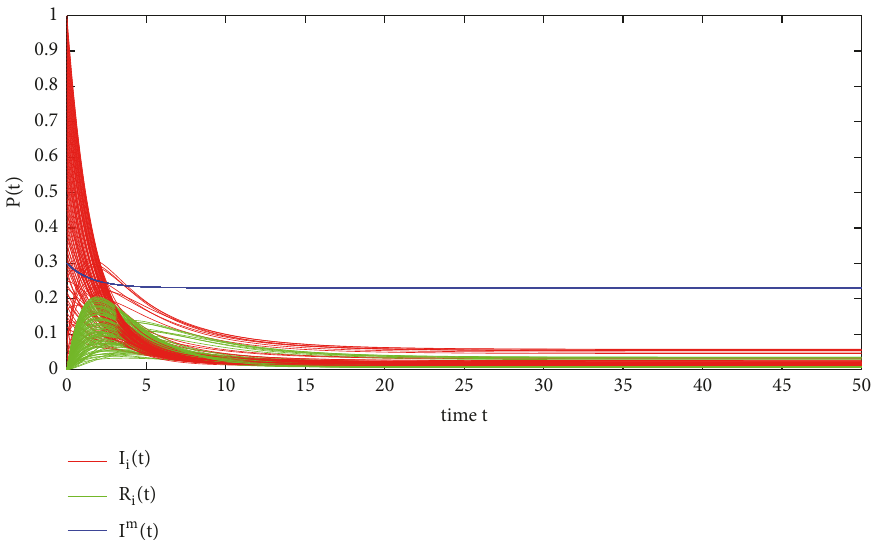
Figure 3: The states 𝐼 𝑖 (𝑡) , 𝑅 𝑖 (𝑡) , and 𝐼 𝑚 (𝑡) of time for NW small-world networks and random initial